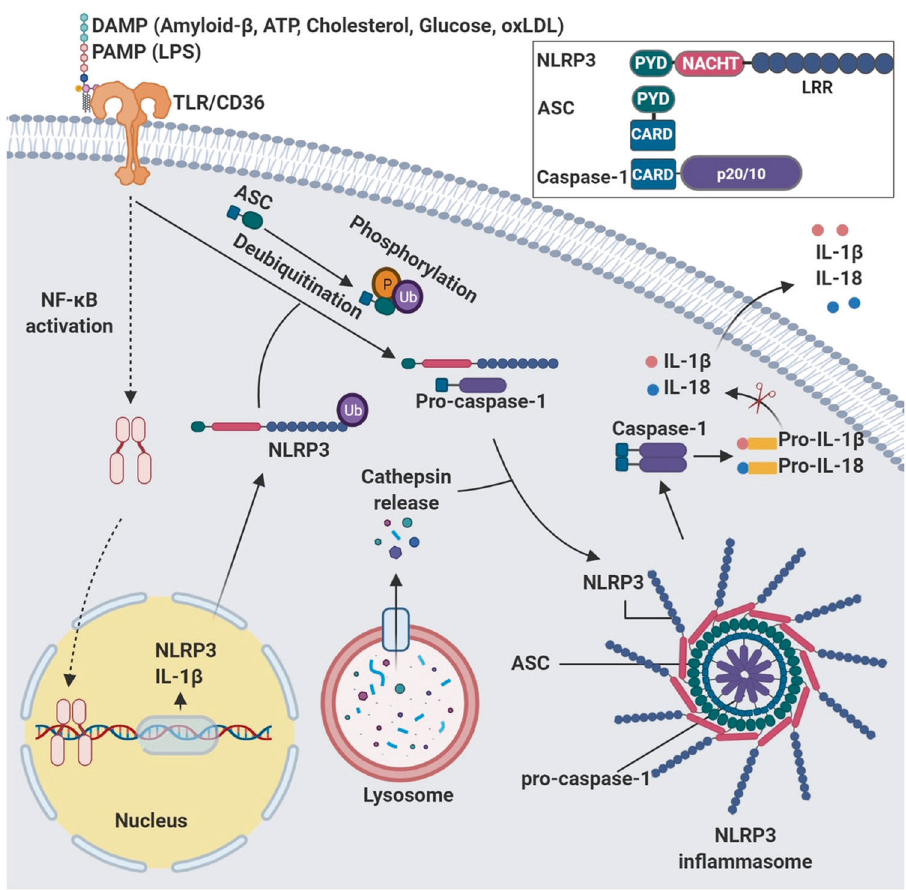
Fig. 1 Mechanisms of NLRP3 in fl ammasome assembly and activation. NLRP3 needs to be primed prior to activation. The priming process includes the binding of PAMPs/DAMPs to TLR or CD36, which promotes the transcription of NLRP3 and IL-1 β . The priming event also includes de-ubiquitination of NLRP3. The ubiquitination and phosphorylation of the adaptor protein ASC is also necessary for the assembly of in fl ammasome. Disruption of the lysosome and release of cathepsin enhances the activation of NLRP3 in fl ammasome. The assembly of activated in fl ammasome leads to the processing of pro-caspase-1 into mature and active enzyme, which in turn cleaves pro-IL-1 β and pro-IL- 18 into active cytokines. Inset: activated NLRP3 binds to ASC through PYD – PYD interactions. Pro-caspase-1 binds to ASC through CARD – CARD